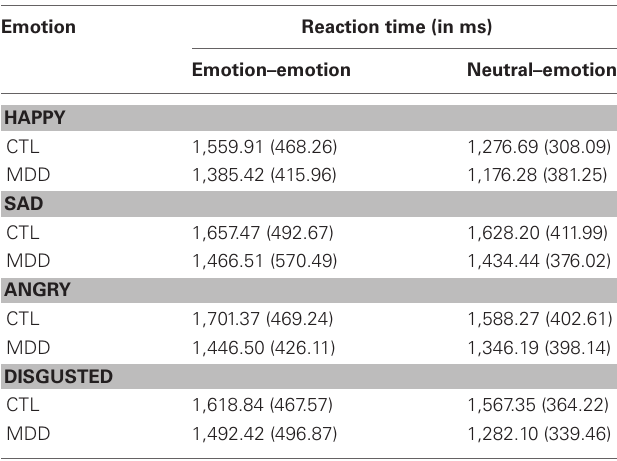
Table 3 | Priming data by emotion and trial type.